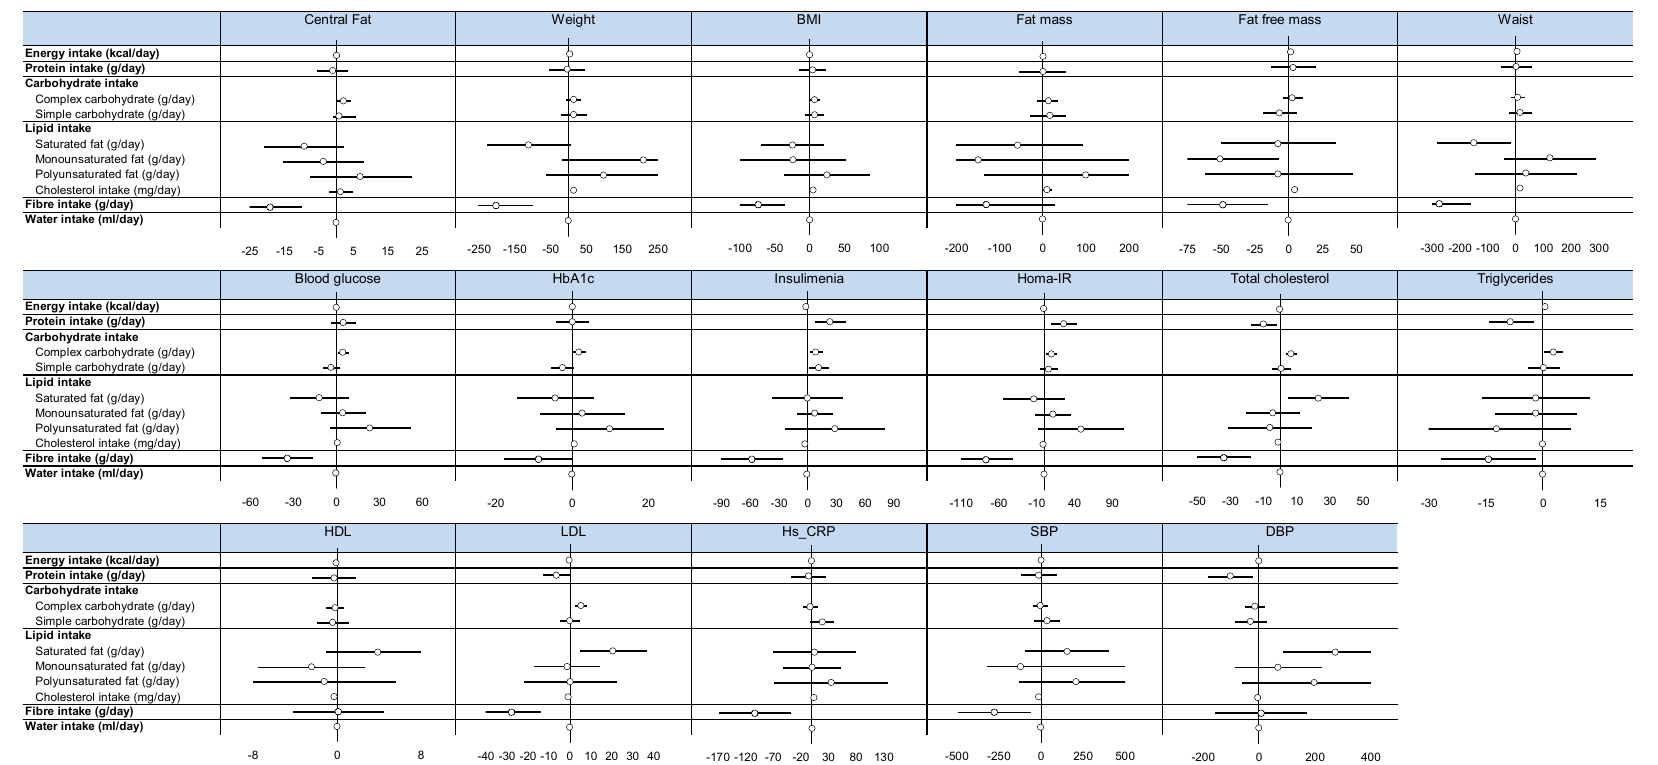
Figure 2. Effect of nutritional factors on health outcomes—Forest plots represent effect sizes (dot) and their 95% confidence intervals (horizontal lines on both sides). For details, please see supplementary Table l . Data are adjusted on age. The effect of each variable on the outcome is represented in the forest-plot by a dot on a horizontal line. The black dots represent the coefficient for each variable, and the length of each line around the dots represent its 95% confidence interval (95CI). The black solid vertical line represents the null estimate (with a value of 0). Horizontal lines that cross the null vertical line represent non-significant variables on the outcome. HbA1c: glycated hemoglobin; Homa-IR: Homeostatic Model Assessment of Insulin Resistance, HDL: high-density lipoprotein, LDL: low-density lipoprotein, Hs-CRP: high-sensitivity C—reactive protein. BMI: Body Mass Index. SBP: systolic blood pressure; DBP: diastolic blood pressure.